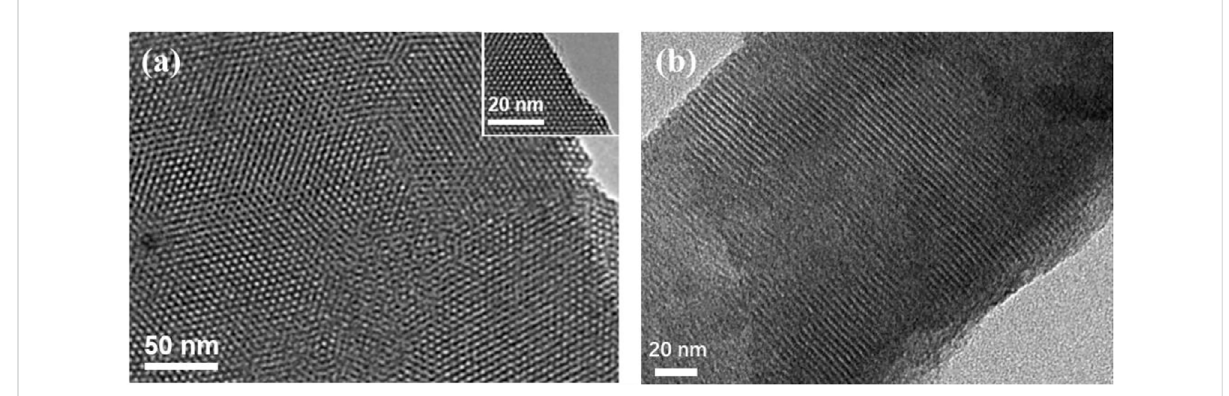
FIGURE 4 Top-view (A) and cross-sectional (B) TEM images of VMSF at different magni fi